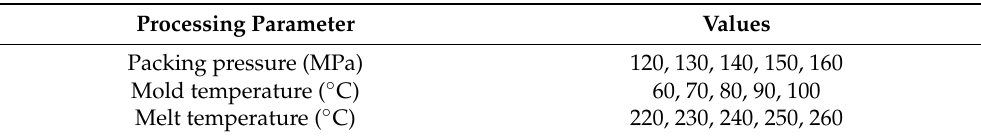
Table 3. Processing parameters used in the experiments. Table 3 lists the processing parameters used in the experiments. To ensure the ac- curacy of the measurements, samples were taken from the sixth product of each set of processing parameters.